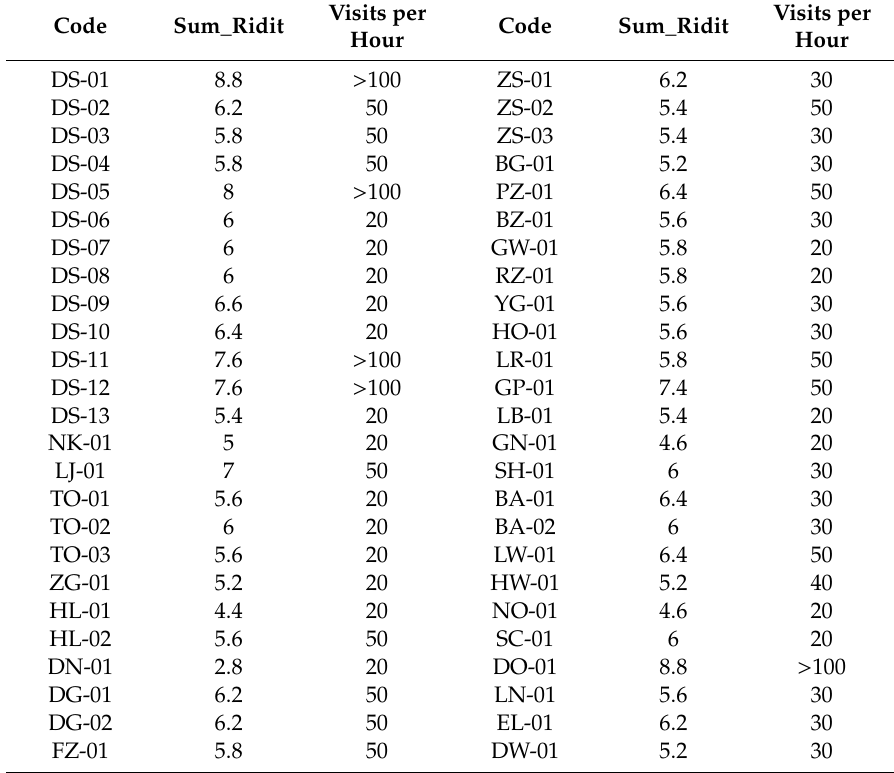
Table 4. Distribution of the Comfortable Water Environment Rest Assessment Form (CWERAF) scores and number of tourists in 50 survey